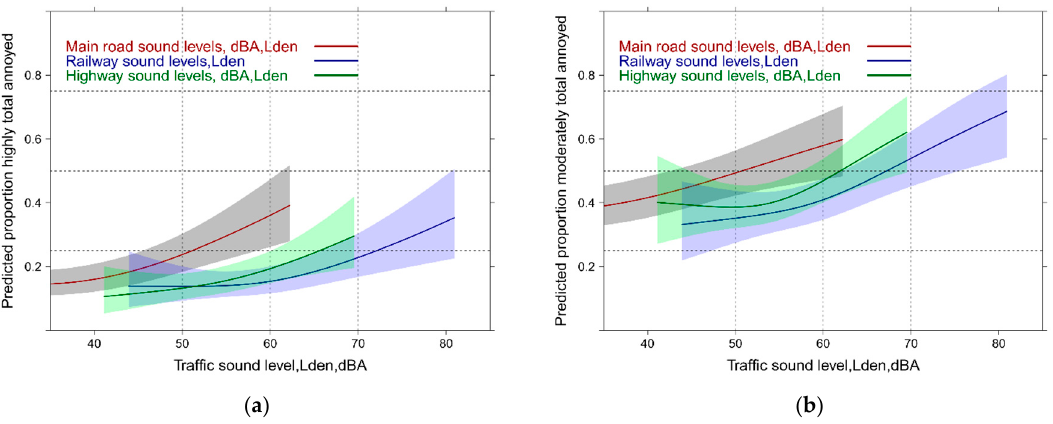
Figure 4. Predicted proportion of total annoyance associated with sound source level (Lden, dBA). ( a ) Proportion highly annoyed; ( b ) Proportion moderately annoyed. Adjusted for age, sex, education, noise sensitivity, health status and the other sound sources.